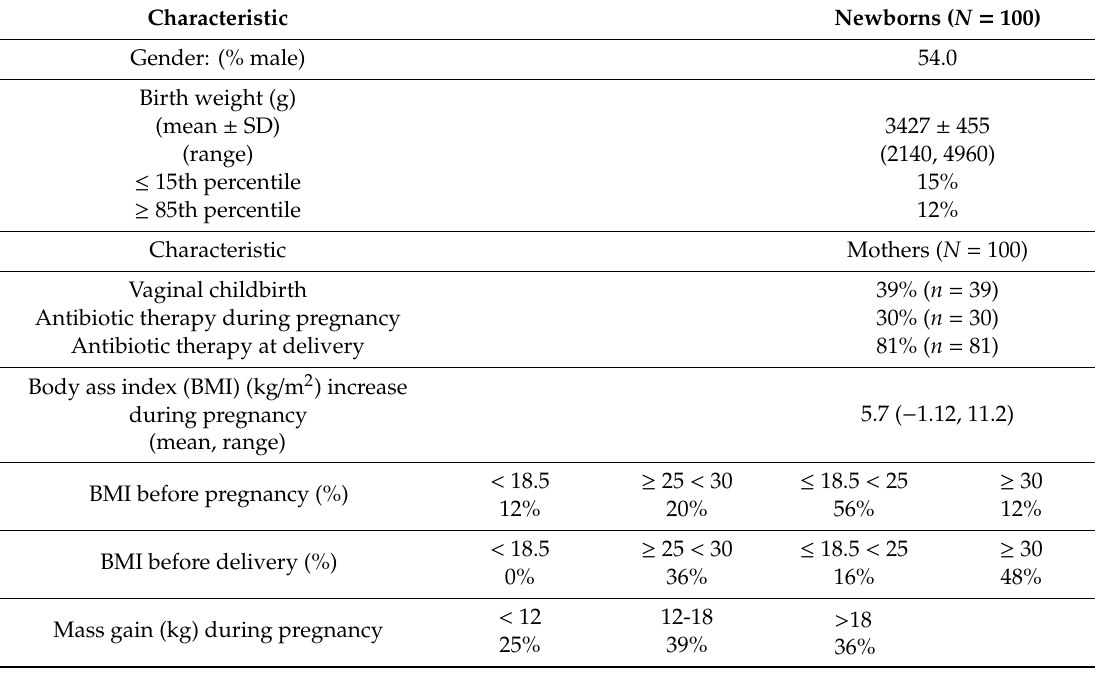
Table 1. Group characteristics: mothers and newborns.